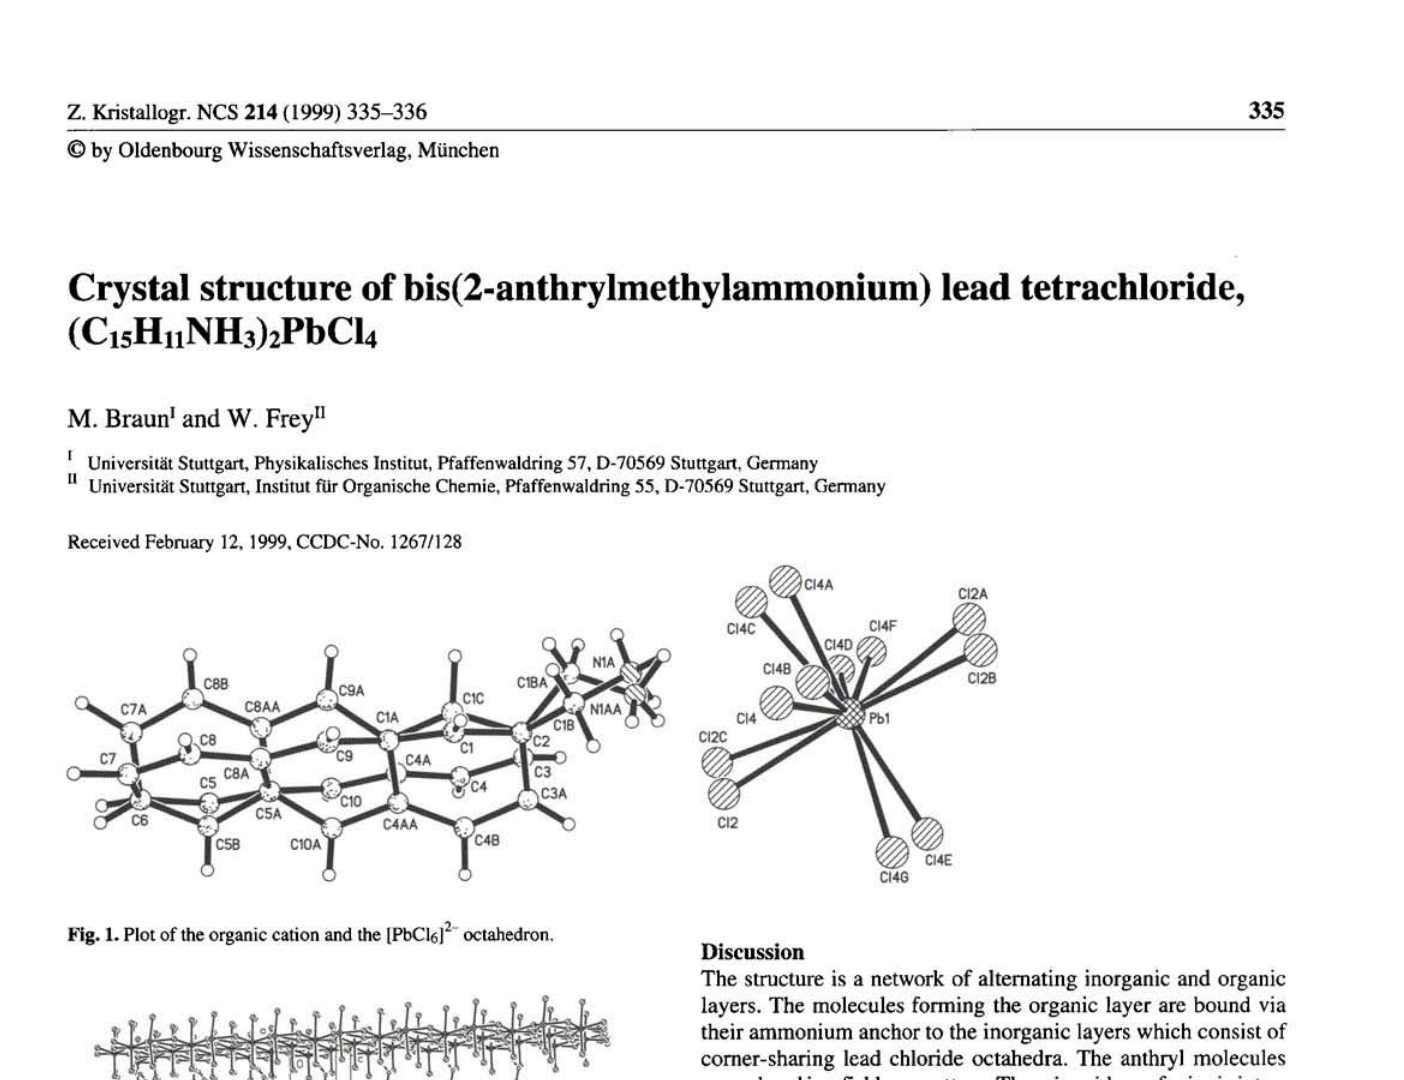
Fig. 1. Plot of the organic cation and the [PbClö] octahedron.